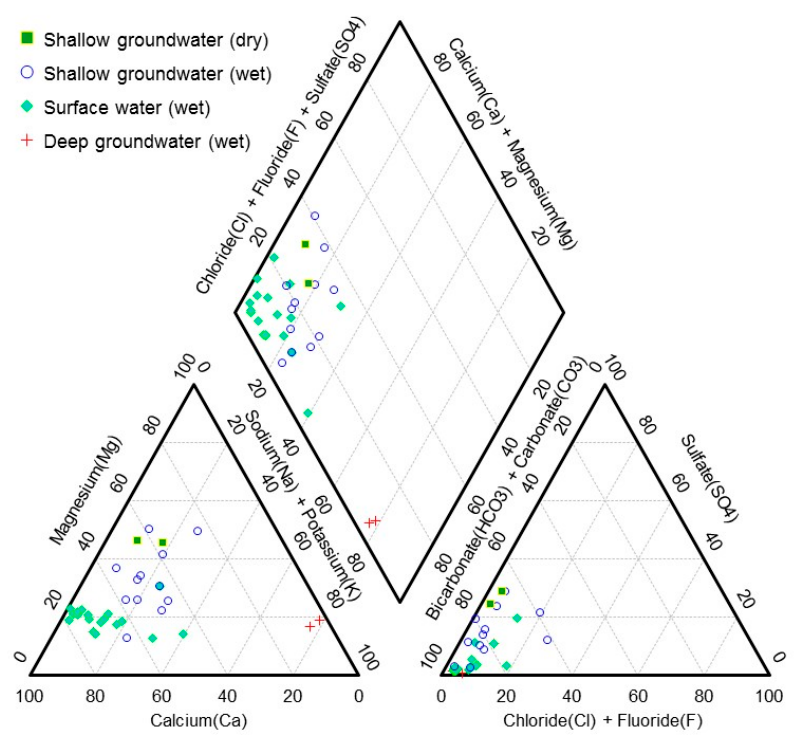
Figure 5. Piper plot of hydrochemistry by water source and season.